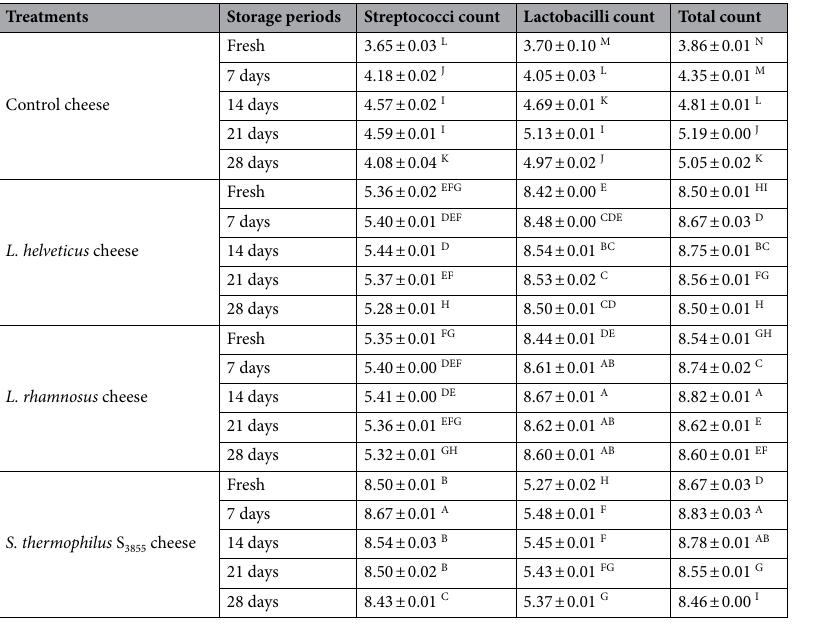
Table 2. Microbiological analysis (log cfu/g) of white soft cheese held at refrigerator temperatures up to 28 days. Means, in the same column, followed by the same letter are not significantly different at a probability level of 0.05.